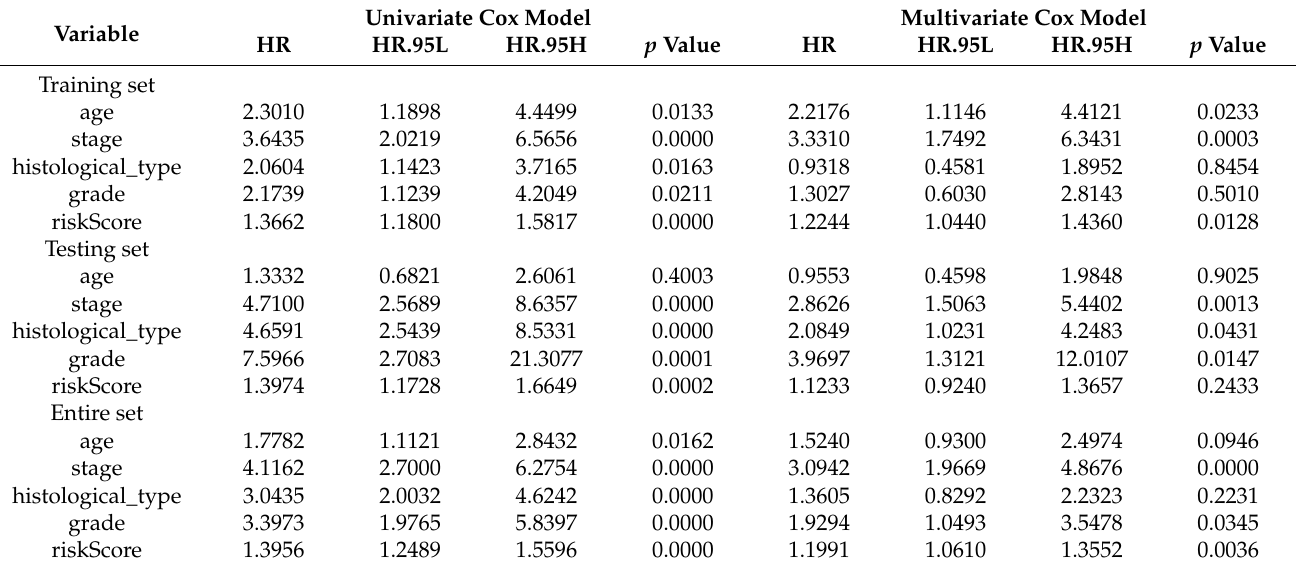
Table 1. Univariate and multivariate Cox model result of the training set, testing set, and entire